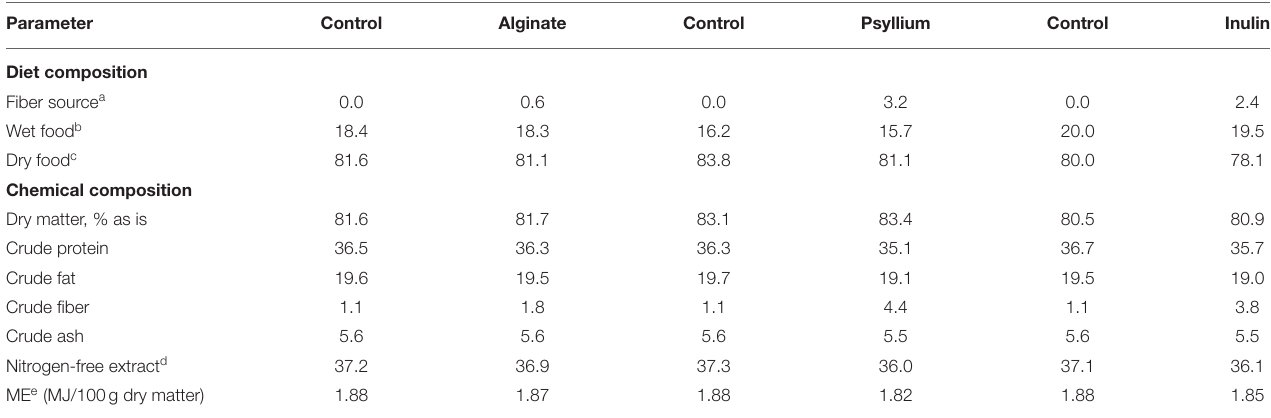
TABLE 3 | Composition (% as is) and calculated chemical composition (g/100g dry matter unless defined differently) of fiber-enriched foods and their respective control foods fed as morning meal. Parameter Control Alginate Control Psyllium Control Inulin Diet